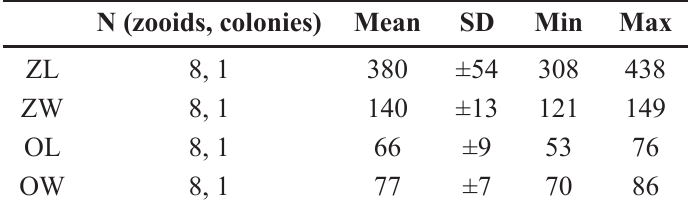
Table 1. Measurements in microns of Buskia waiinuensis sp. nov., Nukumaruan, Pleistocene, Nukumaru Limestone.